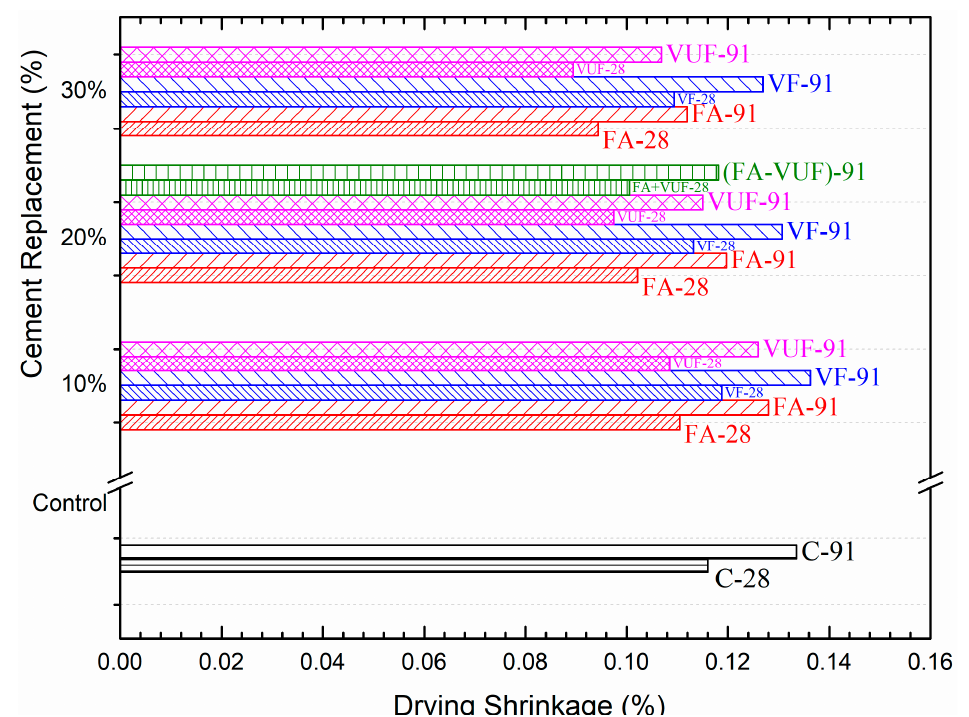
Figure 10. Comparison of drying shrinkage between the control mortar and mortars containing different percentages of FA, VF and VUF at 28 and 91 days.